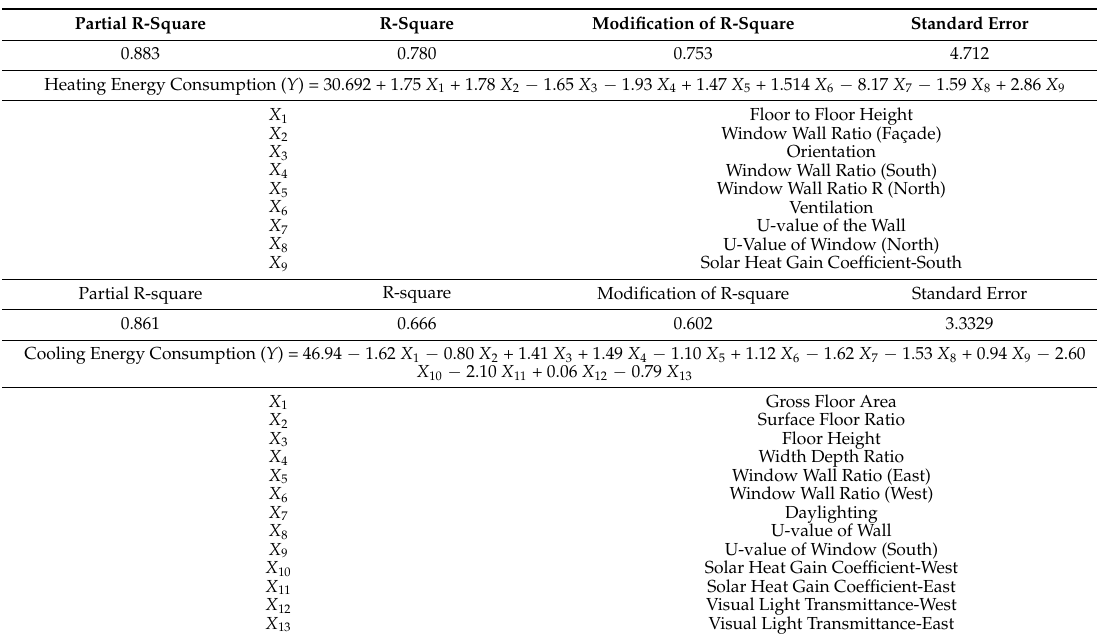
Table 7. Equations for Energy Consumption